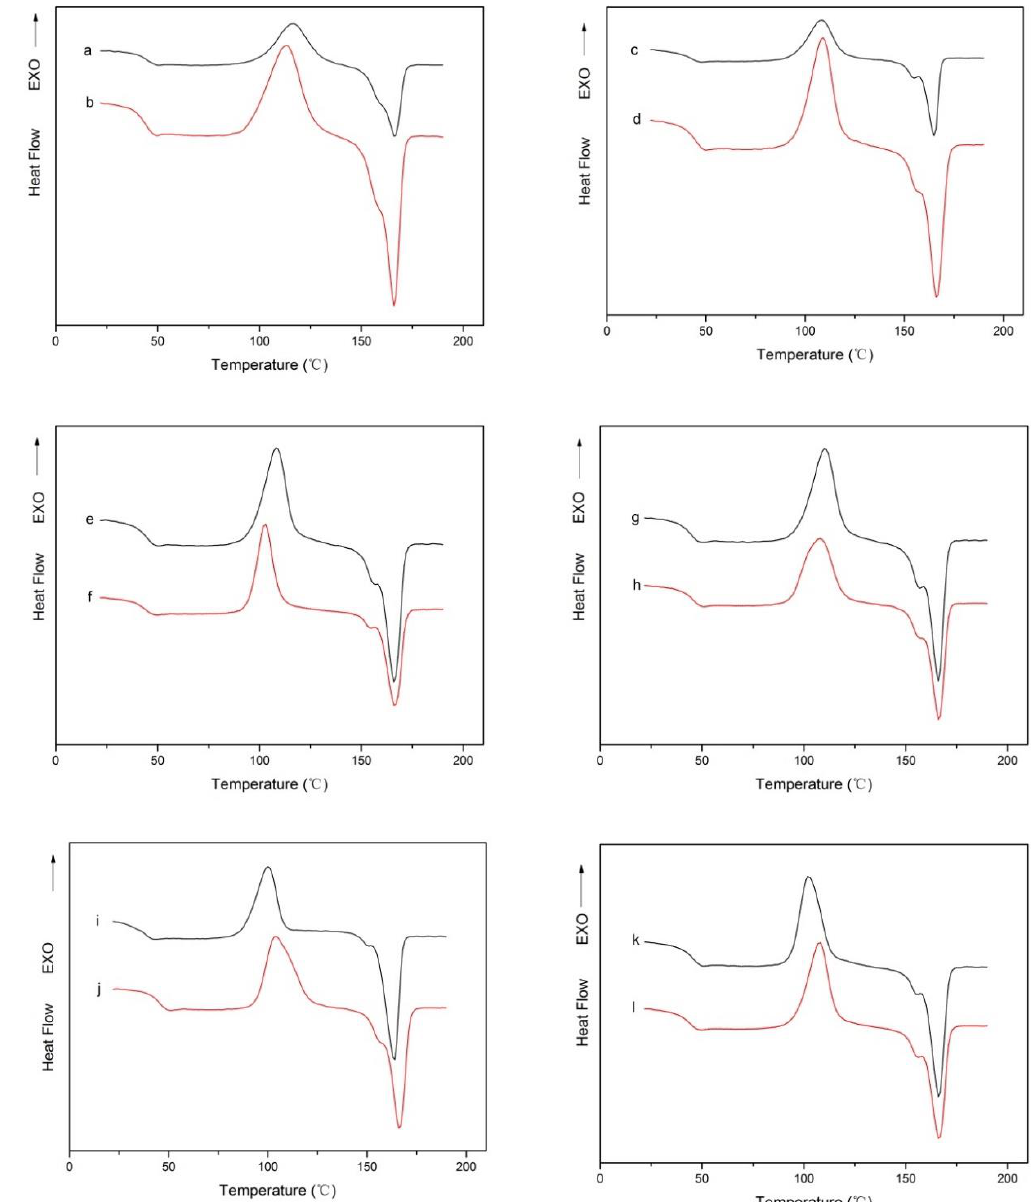
Figure 3. ( a , c , e , g , i , k ) represents the DSC curve of composite film PLA-0, PLA-1%, PLA-5%, PLA-10%, Figure 3. ( a ), ( c ), ( e ), ( g ), ( i ) and ( k ) represents the DSC curve of composite film PLA-0, PLA-1%, PLA- PLA-15% and PLA-20% before high pressure treatment, respectively; ( b , d , f , h , j , l ) represents the DSC 5%, PLA-10%, PLA-15% and PLA-20% before high pressure treatment, respectively; ( b ), ( d ), ( f ), ( h ), curve of composite film PLA-0, PLA-1%, PLA-5%, PLA-10%, PLA-15% and PLA-20% after high pressure treatment,